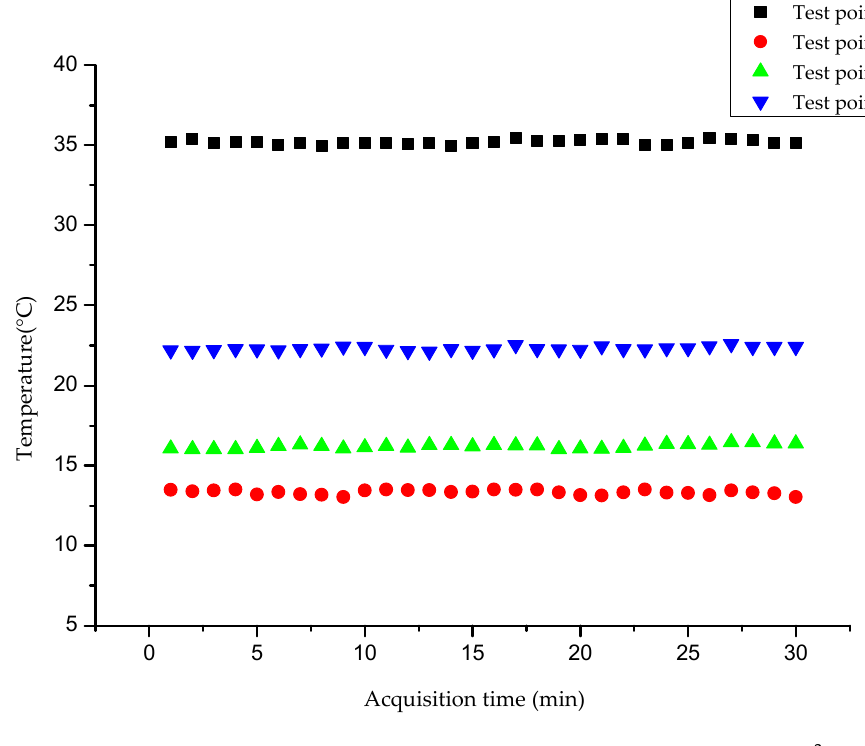
Figure 8. Temperature data collection of four test points at 35 °C, 80%, 0.3 m 3 /s.